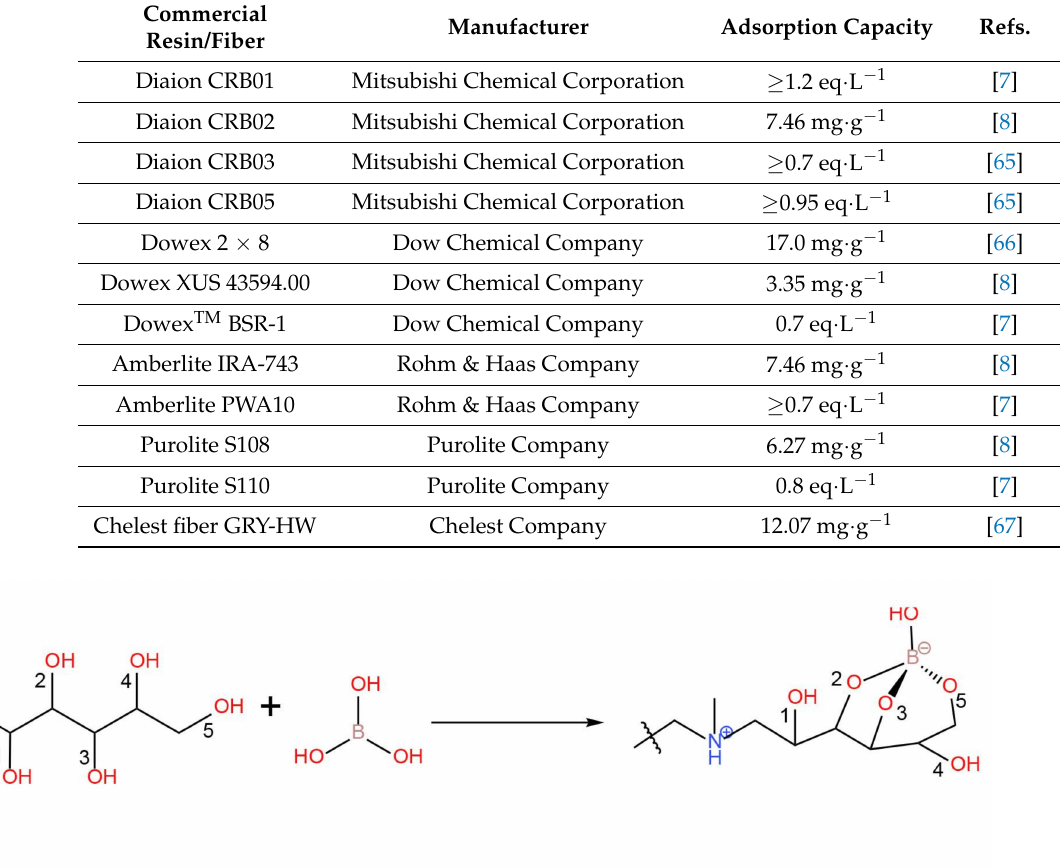
Table 8. Characteristics of different commercial resins and fibers.